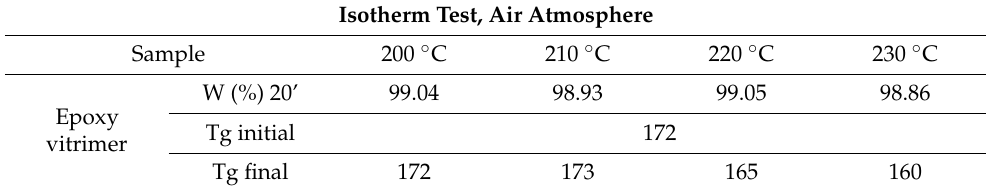
Figure 2. Thermal stability of epoxy vitrimer in air. Table 2. Thermal stability of epoxy vitrimer. The initial Tg of the sample and the Tg after isothermal conditions are also shown.